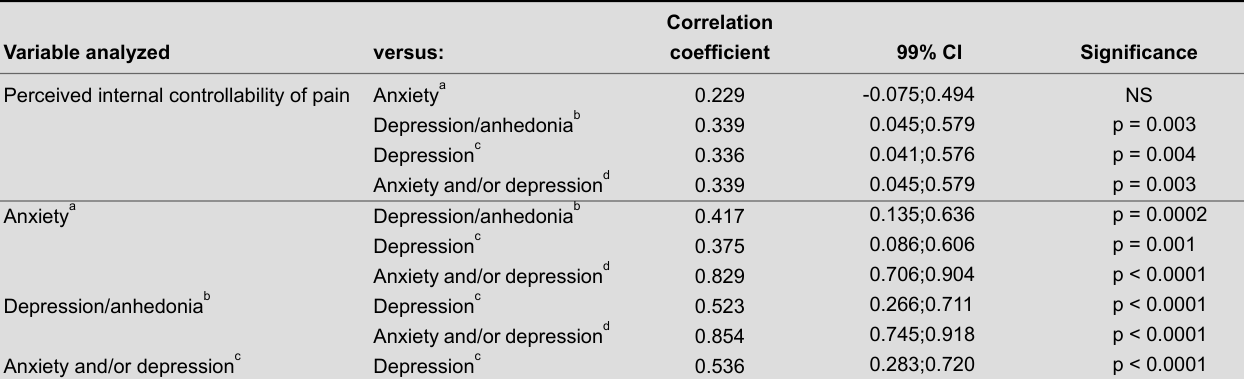
Relationships Between Perceived Internal Controllability of Pain and Anxiety Alone, Depression/anhedonia, Depression Alone or Anxiety and/or Depression, and Between the Components of Emotional Distress Themselves, in Cluster Headache Patients CICorrelation Significance99% coefficientversus:Variable analyzed NS0.229Anxiety a Perceived internal controllability of